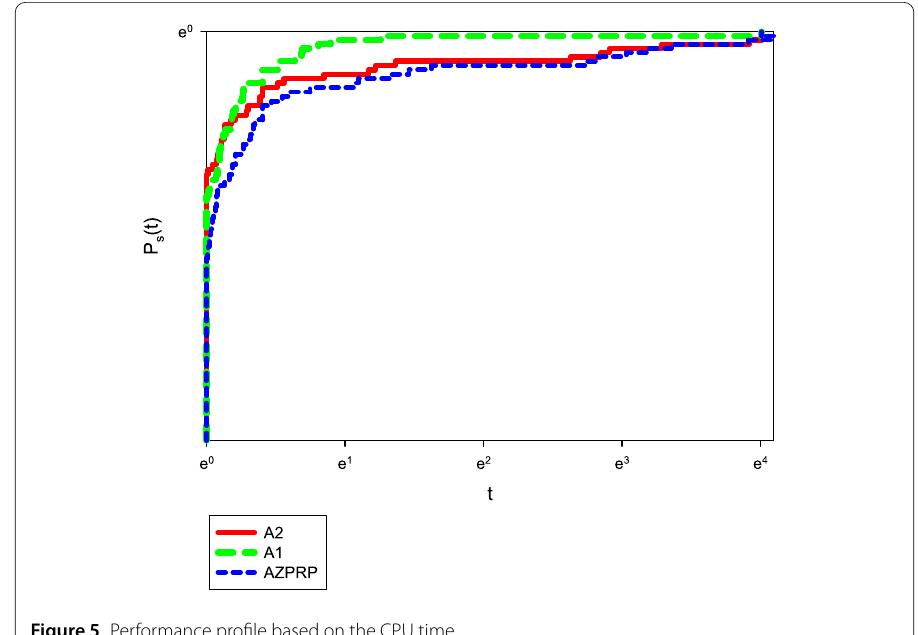
Figure 5 Performance profile based on the CPU time